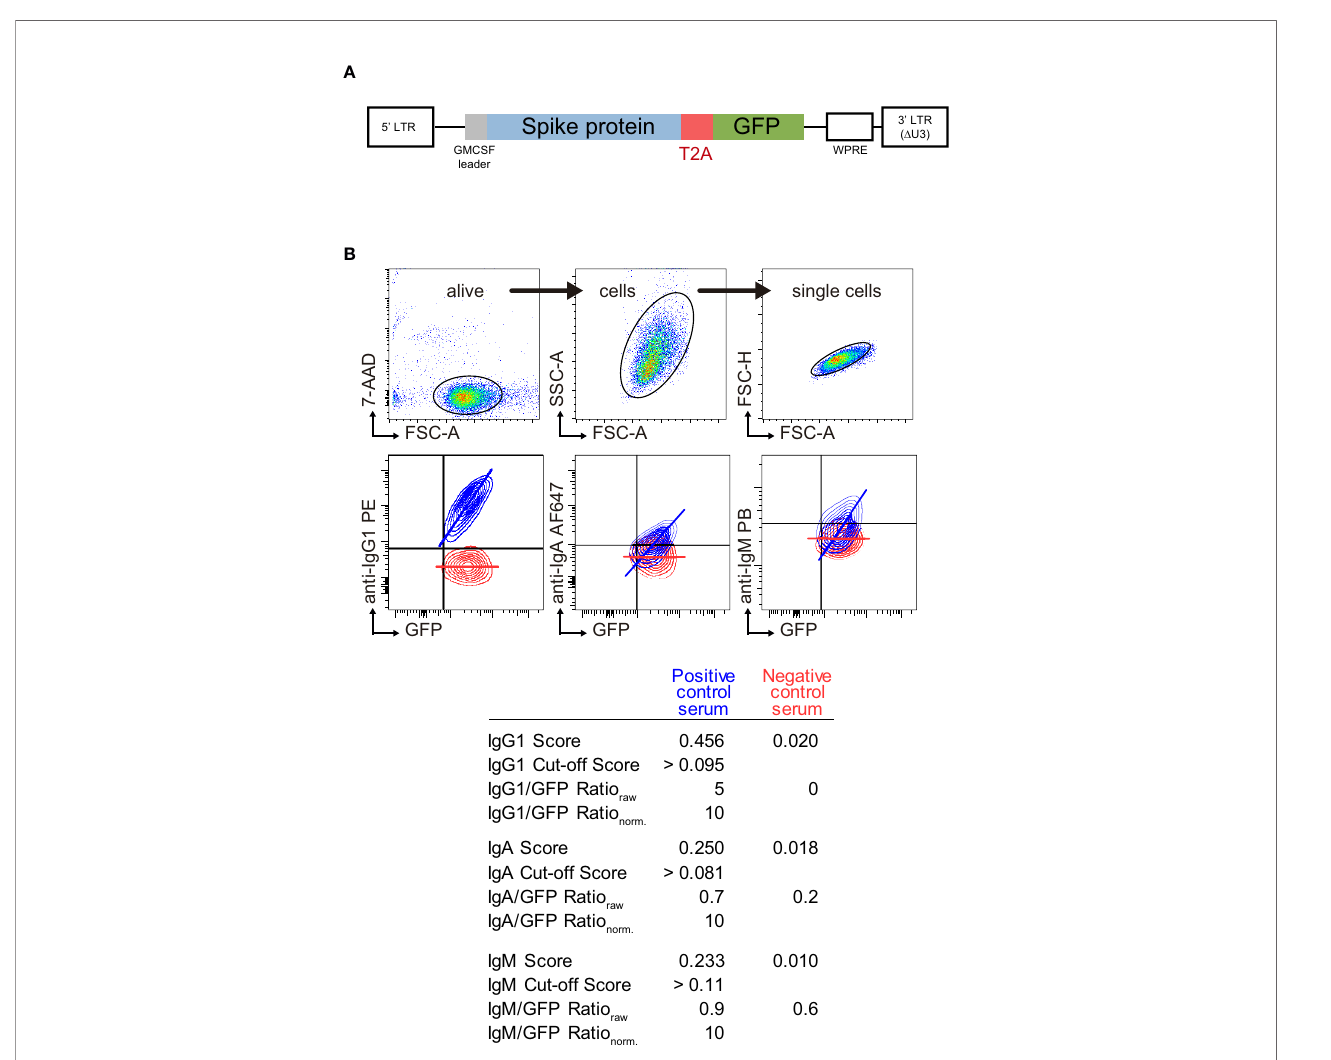
FIGURE 1 | SARS-CoV-2 S Jurkat Flow-Cytometry Immunoassay (JFCI) method. (A) Lentiviral construct used to generate Jurkat S GFP cells. Full length mature SARS-CoV-2 Spike protein is followed by the T2A processing viral sequence and GFP. (B) Dot plots showing the gating strategy (top) for alive (7-AAD - ), single cells and overlay contour plots of Jurkat S GFP cells stained with positive (blue) and negative (red) pool of sera (bottom). GFP and the three isotype signals are depicted. Score, cut-off value, raw and normalized ratio for each sample and isotype are indicated in the